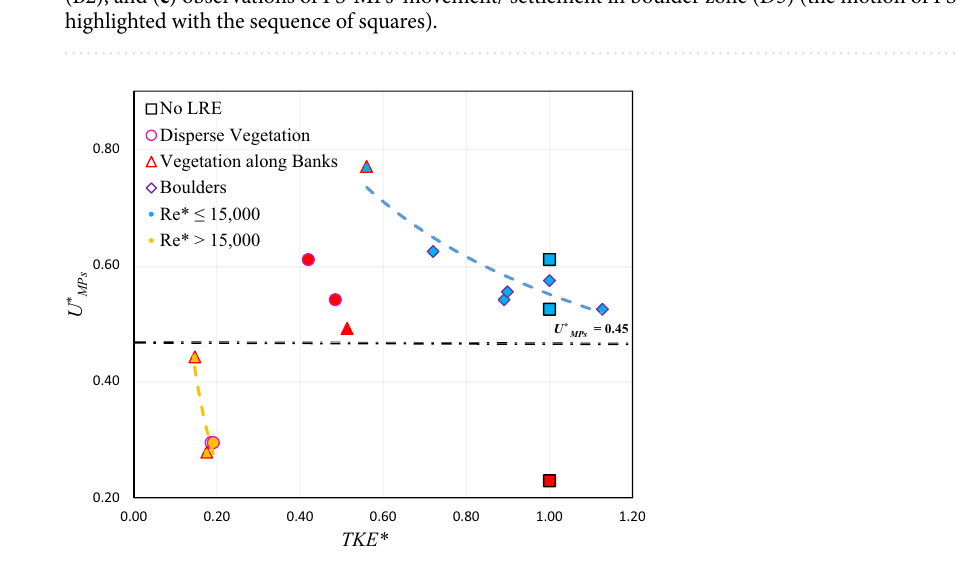
Figure 4. Shows the relationship between dimensionless microplastics velocity ( U ∗ MPs ) and dimensionless turbulence kinetic energy ( K ∗ e ). (The red data points are considered outliers and not considered in the nonlinear regression